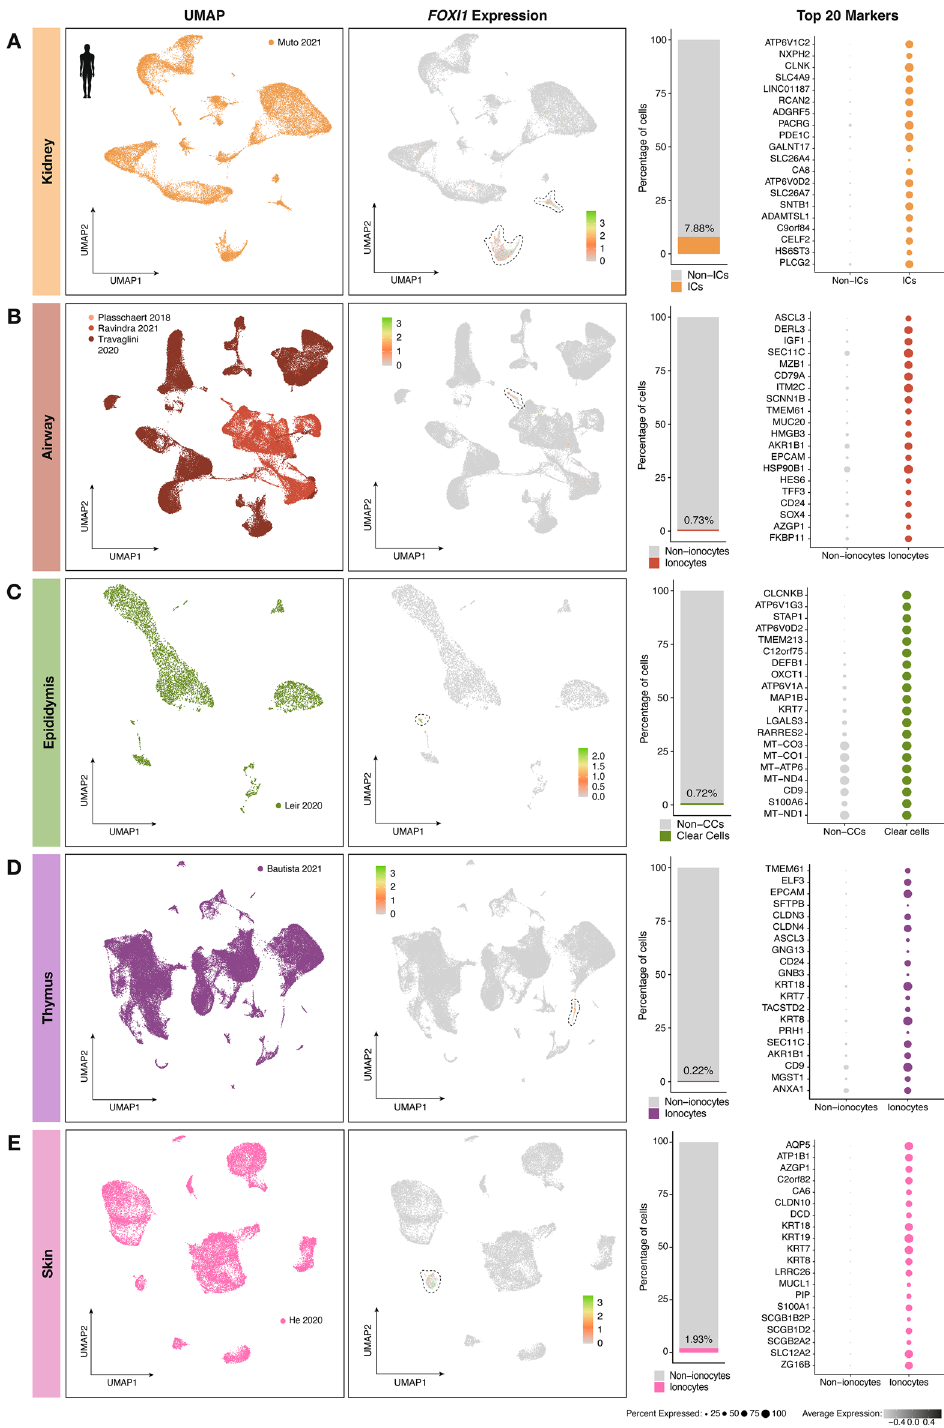
Figure 2. Ionocytes can be identified in several human tissues by having the highest FOXI1 expression. Depicted are the Uniform Manifold Approximation and Projection (UMAP) plots per organ ( A : kidney, B : airway, C : epididymis, D : thymus, E : skin), together with feature plots showing where each FOXI1 -expressing cluster is located, and the percentage of cells found in these ionocyte clusters. Finally, the top 20 differentially expressed markers per ionocyte population can be